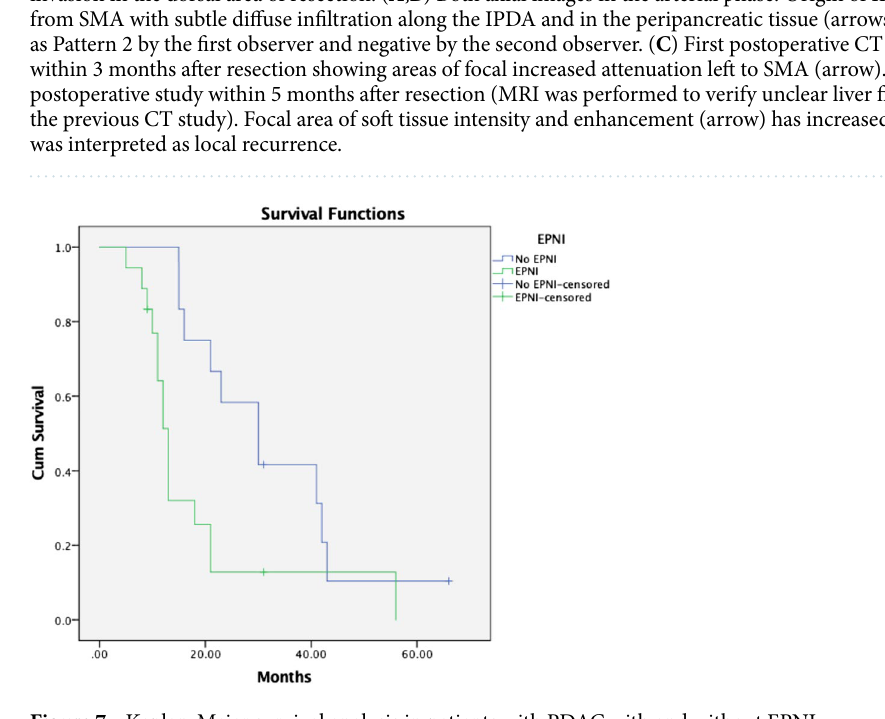
patients with seemingly R0 resection the presence of occult perineural invasion might explain the occurrence of rapid systemic spread or locoregional treatment failure. Current radiological criteria do not include the assess- ment of EPNI 16,17 . We believe that in the shown case (Fig. 6) with local recurrence in R0 resection the cause of the perivascular recurrence was the presence of perineural invasion in the dorsal area of resection, although the tumor stage was pT1c, pN1 (1/14), L0, V0, R0 G2.